Question: Generate an informative caption for the figure above.
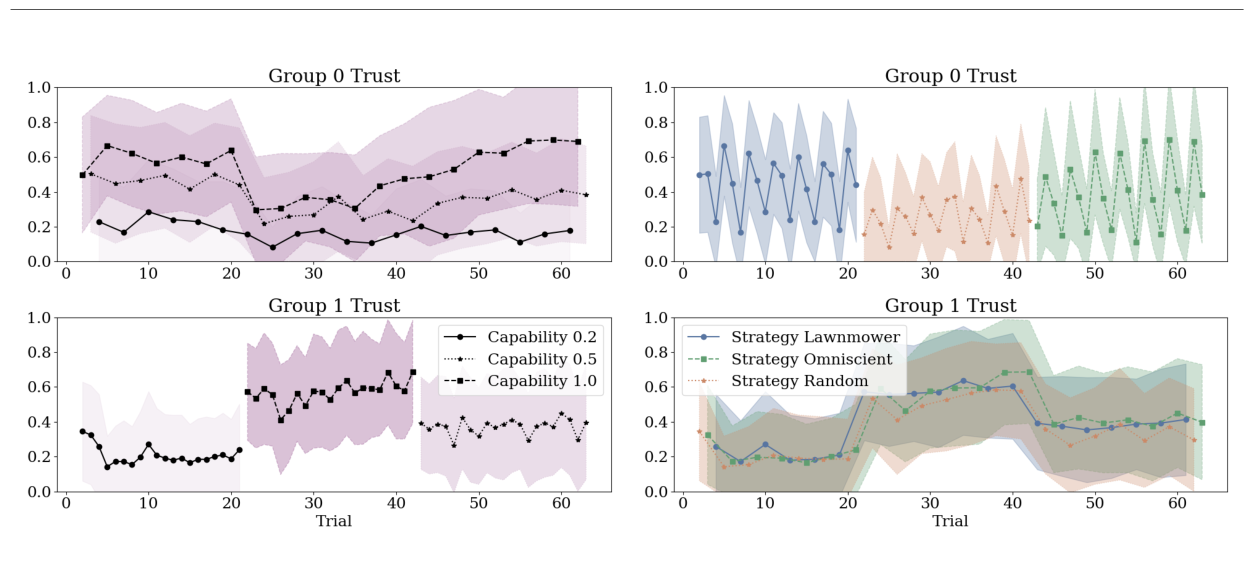
Answer: Each group’s average trust ratings throughout the experiment. The data across rows are the same but colored and connected to emphasize the contributions of each experimental block to the rating. Since capability likely contributes more to an individual’s trust rating and Group 1 saw a constant searcher capability, their ratings were more stable. The oscillations for Group 0 can be attributed to the varying performance of the searchers over a short frequency. The colors in this figure correspond to those in Figure 3.